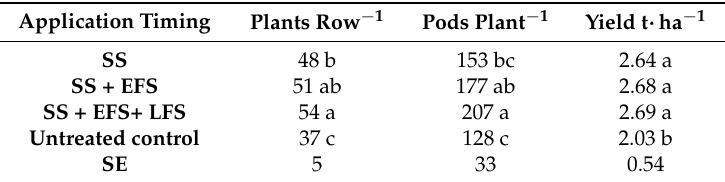
Table 3. Effect of pyraclostrobin application (92.5 g ¨ a.i. ¨ ha ´ 1 ) on stand establishment, pod numbers and yield on the canola hybrid “1950RR” at Edmonton (Crop Diversification Centre North; CDCN) in 2014 and 2015, and at Namao, Alberta, in 2014.